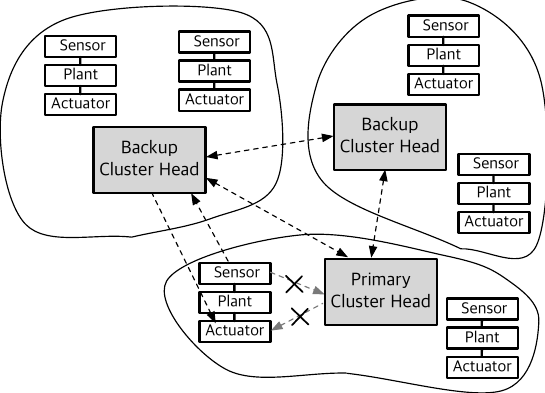
Figure 2. Control task sharing between cluster heads for critical control loops. The critical sensor accesses the backup cluster head through the multiple path. Each cluster head shares the critical sensing information with other cluster heads during the inter-cluster